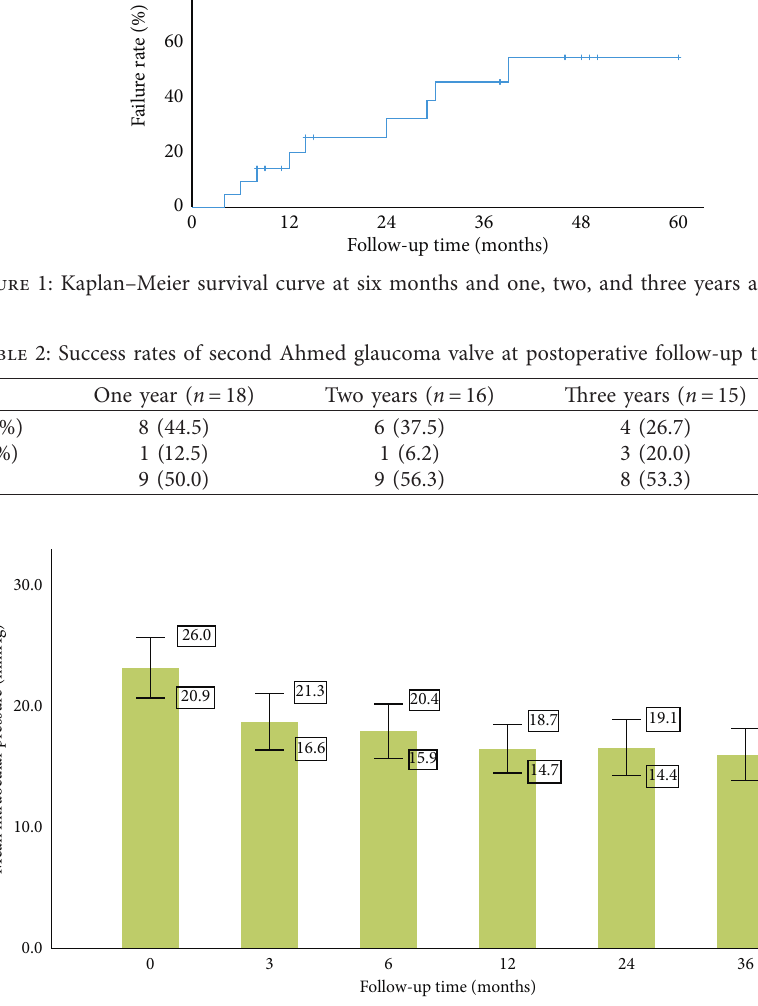
Figure 2: Mean intraocular pressure at preoperative baseline and at various follow-up time points after the implantation of the second Ahmed glaucoma valve. Whiskers represent the 95% confidence interval range of values.